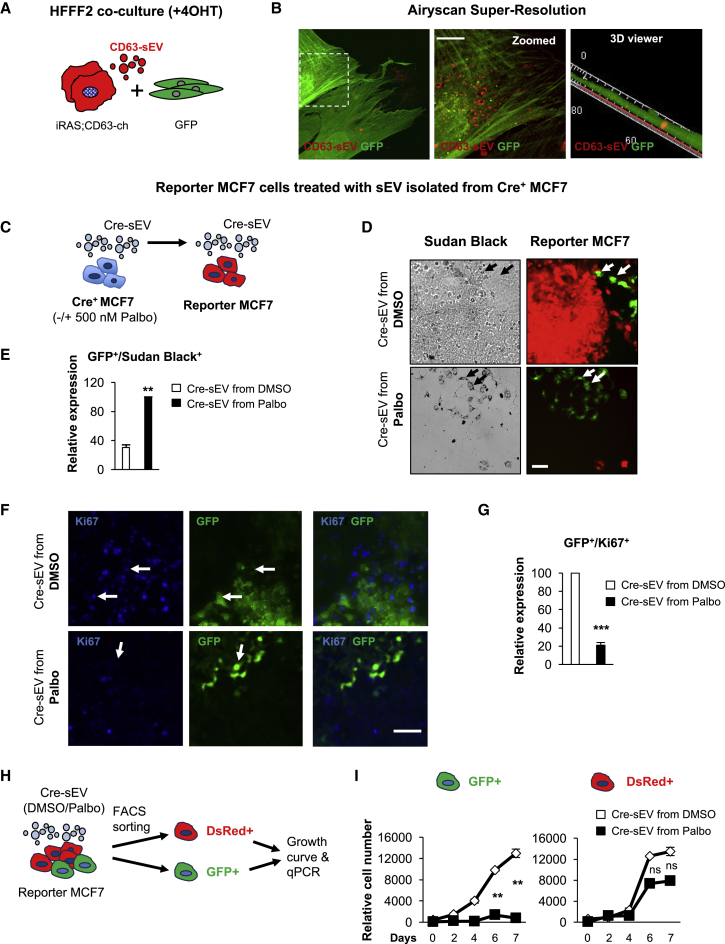
The Uptake of sEVs Derived from Cells Undergoing Senescence Induces Paracrine Senescence(A) Schematic representation of HFFF2 fibroblasts used for the co-culture experiments. Co-culture of HFFF2 expressing a GFP plasmid and iRAS HFFF2 fibroblasts expressing a retroviral construct encoding for mCherry-CD63 (iRAS;CD63-ch). Cells were plated in a 1:1 ratio and treated with 4OHT for 48 h, followed by 3–4 days with fresh media.(B) Representative images showing the uptake of CD63-cherry+ sEVs (CD63-sEV) in GFP cells acquired with the super-resolution microscope Airyscan. Right, a 3D reconstruction of confocal z stack images showing CD63-sEVs inside GFP cells. Scale bar, 20 μm.(C) MCF7 breast cancer cells expressing a Cre recombinase construct (Cre+ MCF7) were treated with DMSO or 500 nM palbociclib (Palbo) for 10 days to induce senescence. sEVs were purified from Cre+ MCF7 cells (Cre-sEV) and used to treat MCF7 cells expressing a fluorescent reporter gene, which switches from expressing DsRed to eGFP upon sEV internalization (reporter MCF7).(D) Representative pictures showing sEV uptake (GFP+ cells) in reporter MCF7s treated with sEVs isolated from Cre+ MCF7 treated with DMSO or Palbo. GFP+ cells are also Sudan Black+.(E) Quantification of the percentage of GFP+ reporter MCF7 treated with sEVs presenting with Sudan Black staining.(F) Pictures display sEV uptake (GFP+) in reporter MCF7 cells incubated with Cre-sEVs from DMSO- or Palbo-treated cells. Arrows show that GFP+ cells treated with Cre-sEV from DMSO cells are also positive for Ki67, while GFP+ cells incubated with Cre-sEV from Palbo-treated cells are negative for Ki67.(G) Quantification of the percentage of GFP+/Ki67+ reporter MCF7 treated with sEVs purified from DMSO- or Palbo-treated Cre+ MCF7.(D and F) Scale bar, 100 μm.(H and I) GFP+ and DsRed+ MCF7 treated with sEVs from both DMSO and Palbo cells were sorted by FACS. (H) Scheme of the experimental settings. (I) Growth curve showing the GFP+ and DsRed+ MCF7 populations.See also Figure S5.